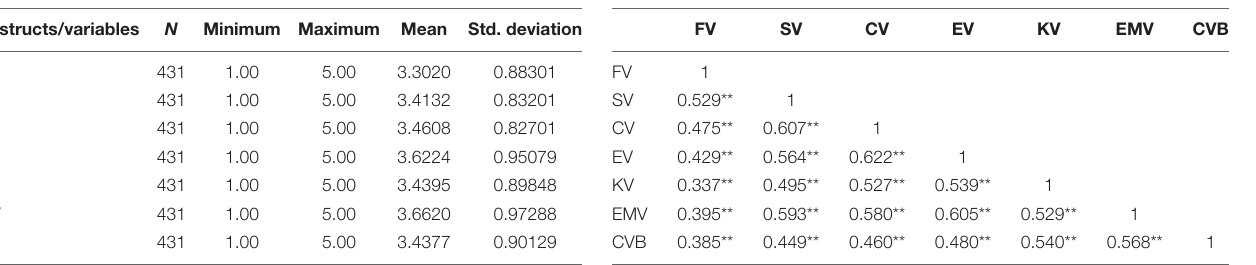
TABLE 7 | Correlation among variables (Pakistan).